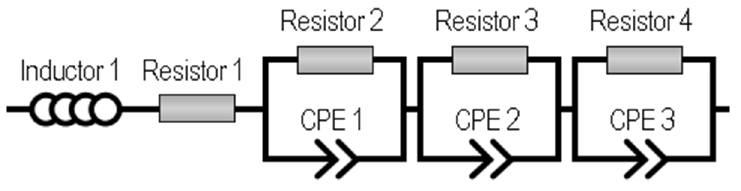
Figure 1. The equivalent circuit model (ECM) used to fit the EIS data.